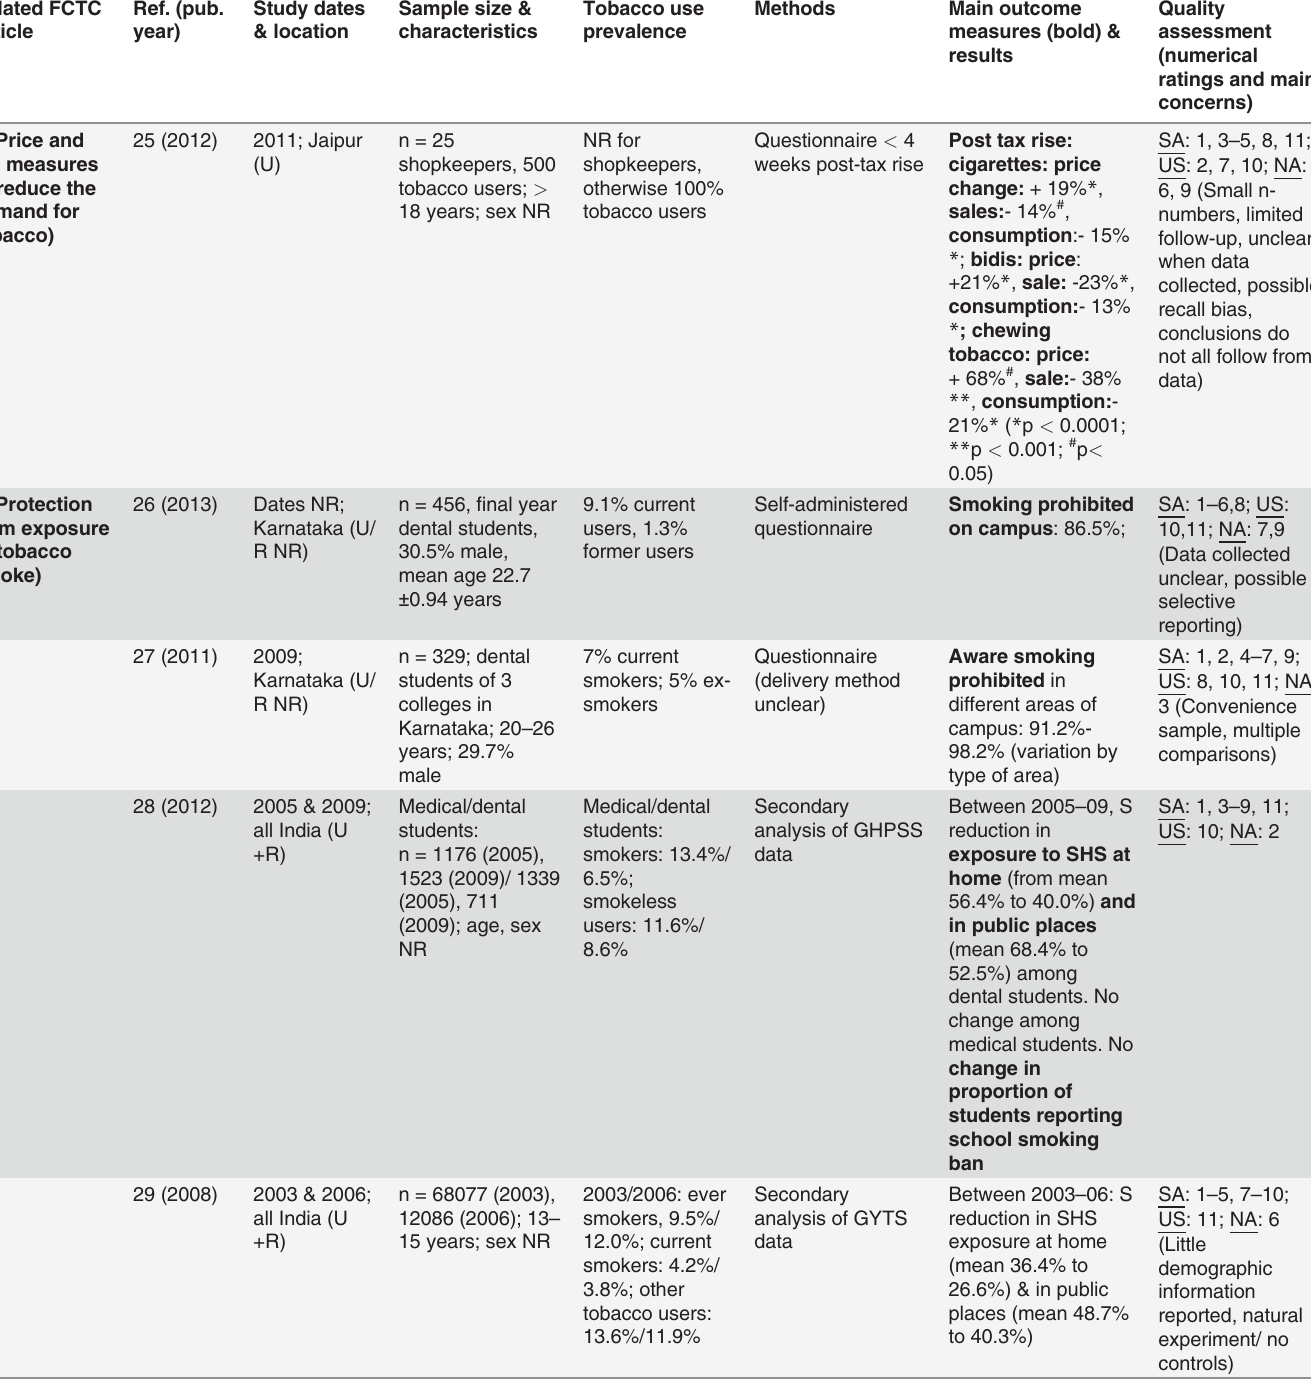
Table 4. Studies related to FCTC articles 6, 8, 11, 13 and